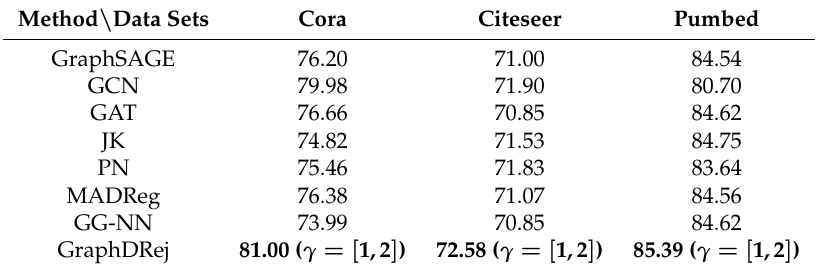
Table 2. Node classification accuracy (%) for two-layer graph neural networks (GNNs). The list in parentheses next to the accuracy of GraphDRej refers to the value set of γ adopted by the corresponding GraphDRej on different data sets.